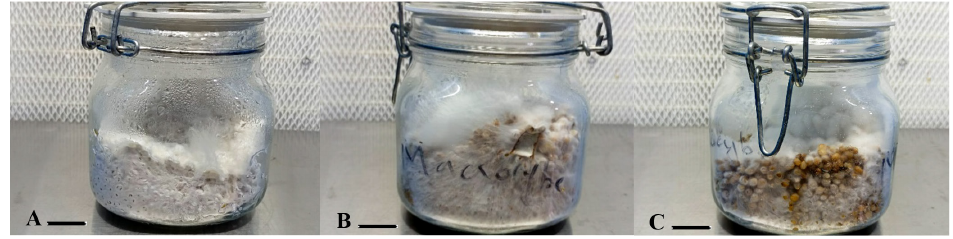
Fig. 2 (A, B, C): Spawn production of M. gigantea on A: sorghum grains; B: wheat grains; C: barley grains at 30 o C after 17 days of inoculation. Scale bar: A-C: 1 cm. M. gigantea . l eon et al. (2017) observed the shortest incubation period for spawn production of wild strain of L. squarrosulus on sorghum grains from the Philippines. These grains were also found to be the good spawning material for Agaricus blazei and Agrocybe aegerita ( g alaMgaM , 2009; M arCelo , 2011). b harti (2019) found wheat grains while P aMitha (2014) and D uong et al. (2017) found paddy grains as the suitable substrate for spawn preparation of M. gigantea . Tab. 2 shows that the days required to complete spawn production of M. gigantea on sorghum, wheat and barley grains at 30 ℃ significantly differed at (p<0.001). Tab. 2: Efficiency of wheat, sorghum and barley grains for spawn production of M. gigantea Types of grains Days required to complete spawn production at 30 °C Sorghum Table 3: Days required to complete Spawn Running Period on different substrates at The results reported were run in triplicates and stated as Mean± Standard error. variable temperatures